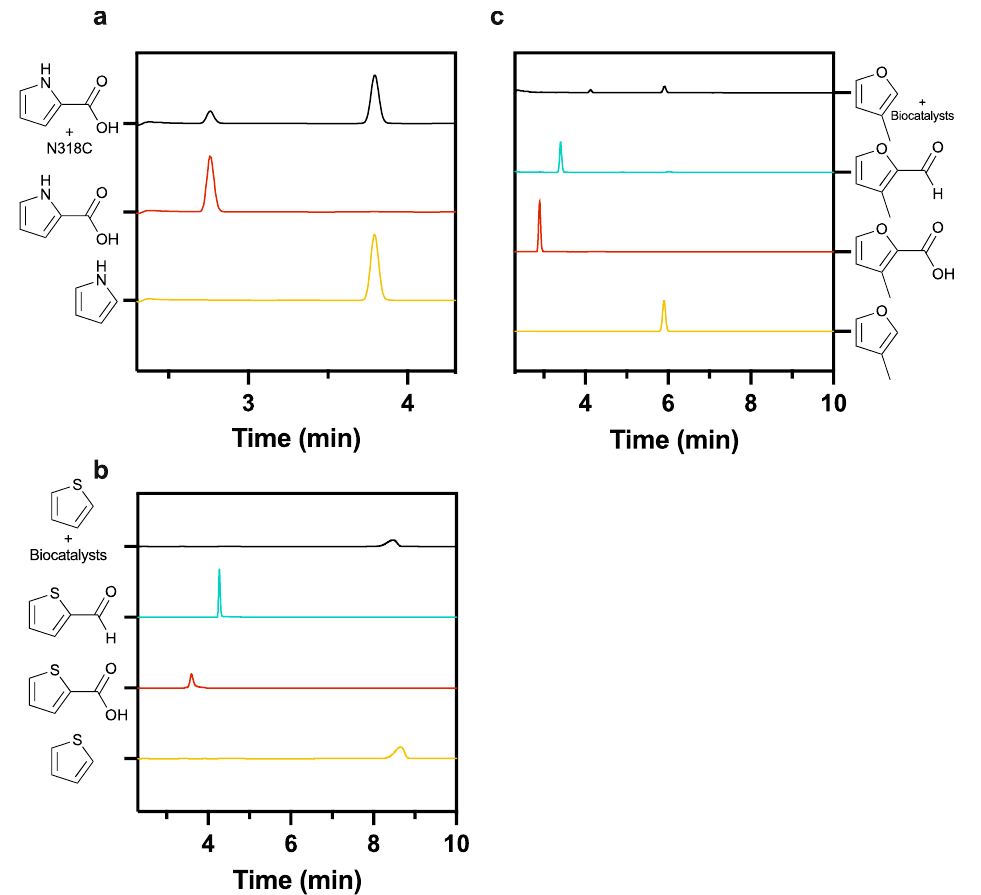
Figure 9. Comparative HPLC trace analysis of biocatalytic reactions utilising purified PA0254-N318C mutant against known compound standards. Incubation of 0.27 mg/mL of N318C with 1 mM pyrrole-2-carboxylic acid yields the formation of pyrrole following incubation at 30 ◦ C ( a ). However, no aldehyde is observed upon the application of purified N318C and whole-cell CARse biocatalysts with either thiophene ( b ) or 3-methylfuran ( c ) as starting substrates.